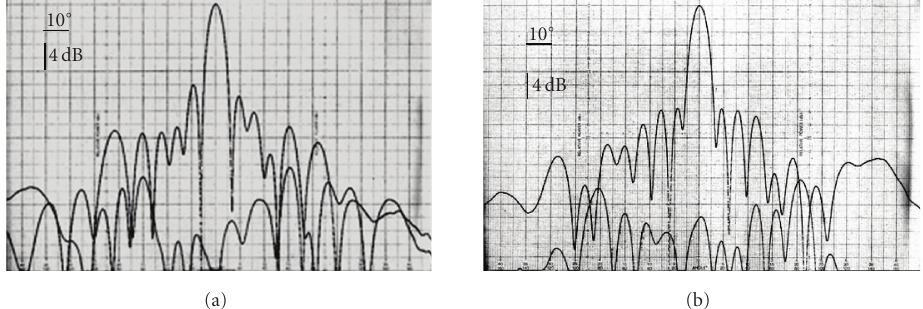
Figure 7: Radiating board measured pattern azimuth plane at 9.6GHz, H & V pol. ( ± 90 ◦ x axis; 40dB y axis).